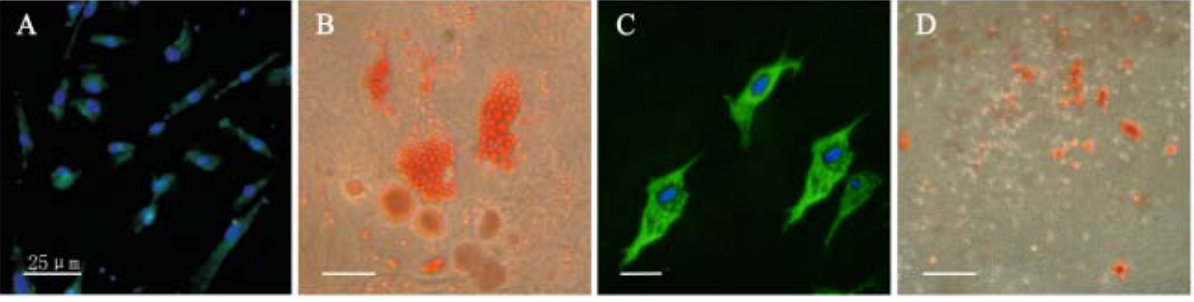
Figure 2. Multilineage differentiation capacity of DPSCs. (original magnification, ×40). ( A ) Cells are positive for STRO-1, staining by immunofluorescence. ( B ) Adipogenic differentiation was shown by the accumulation of neutral lipid vacuoles stainable with Oil Red O. ( C ) Immunofluorescence assay for nestin after 7 days’ indution of DPSCs. ( D ) Osteogenic differentiation was shown by the deposition of a mineralized matrix indicated by Alizarin Red